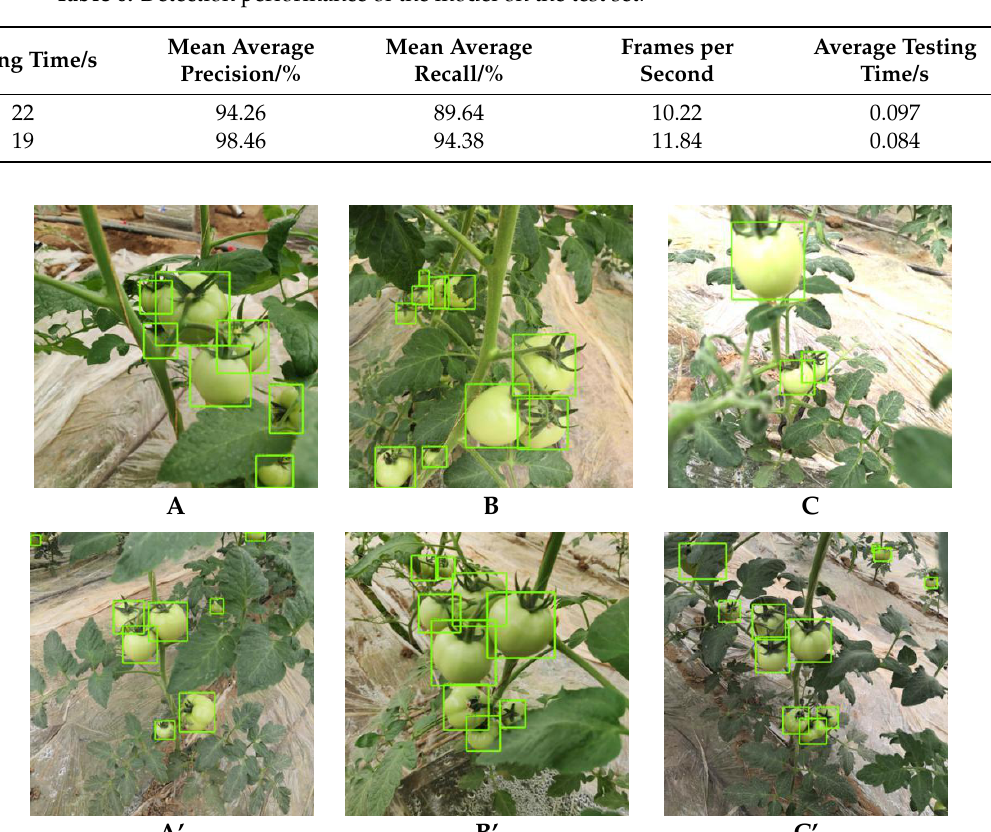
Table 6. Detection performance of the model on the test set.